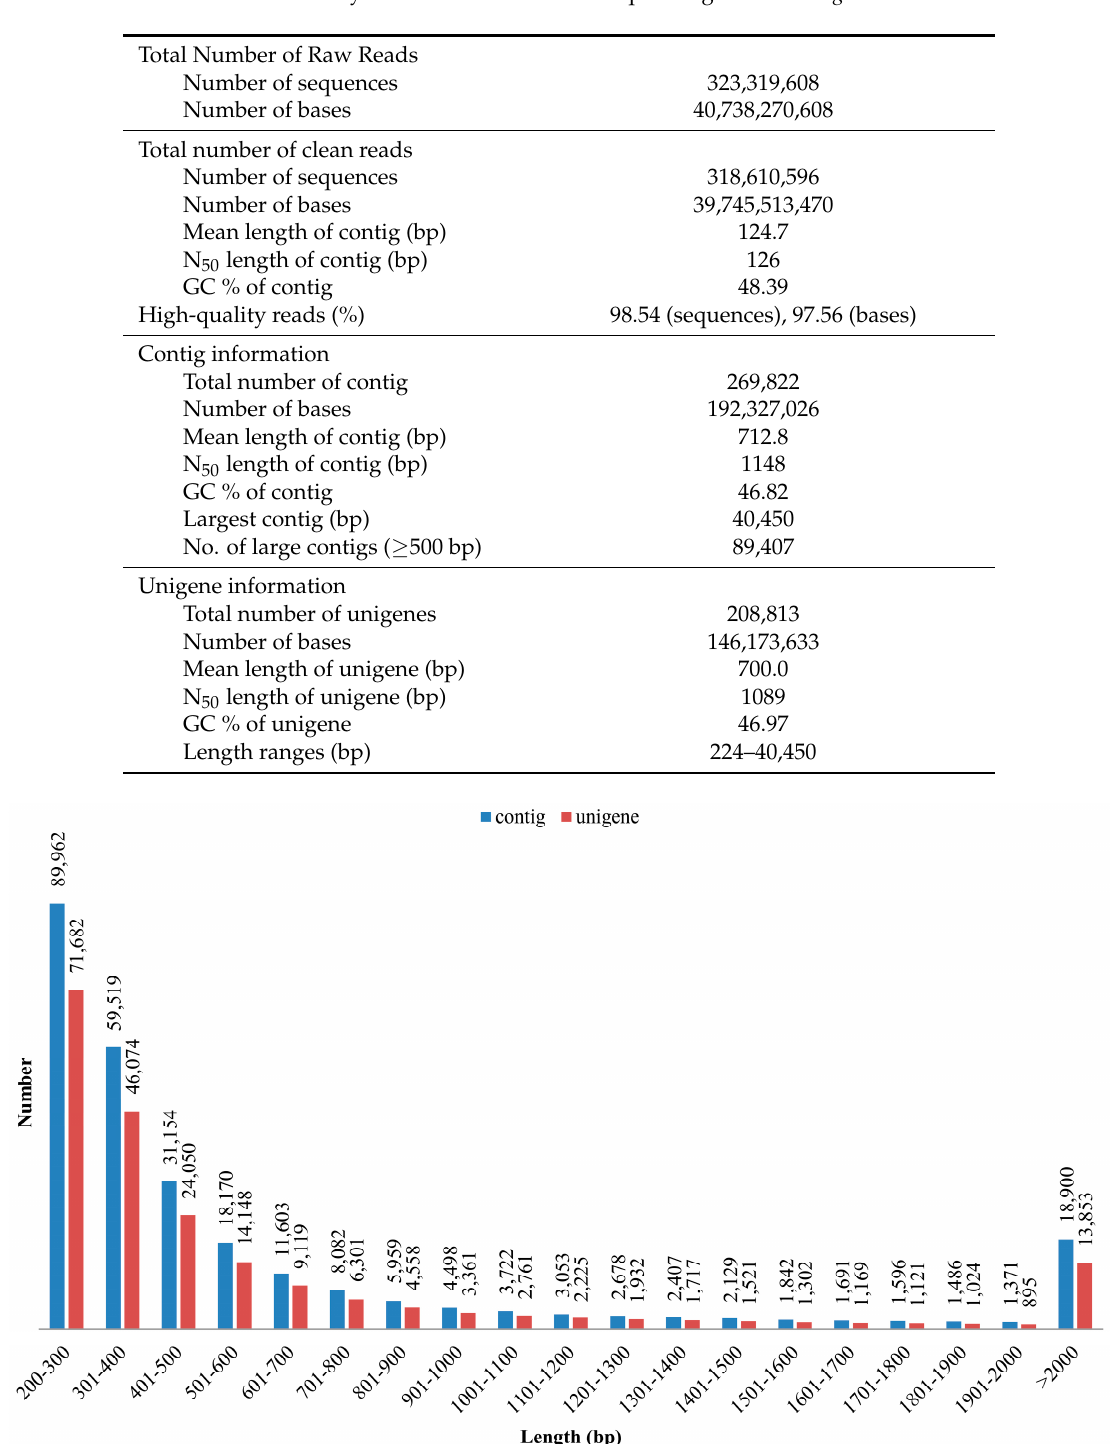
Table 1. Summary statistics from Illumina sequencing of the T. longicaudatus .